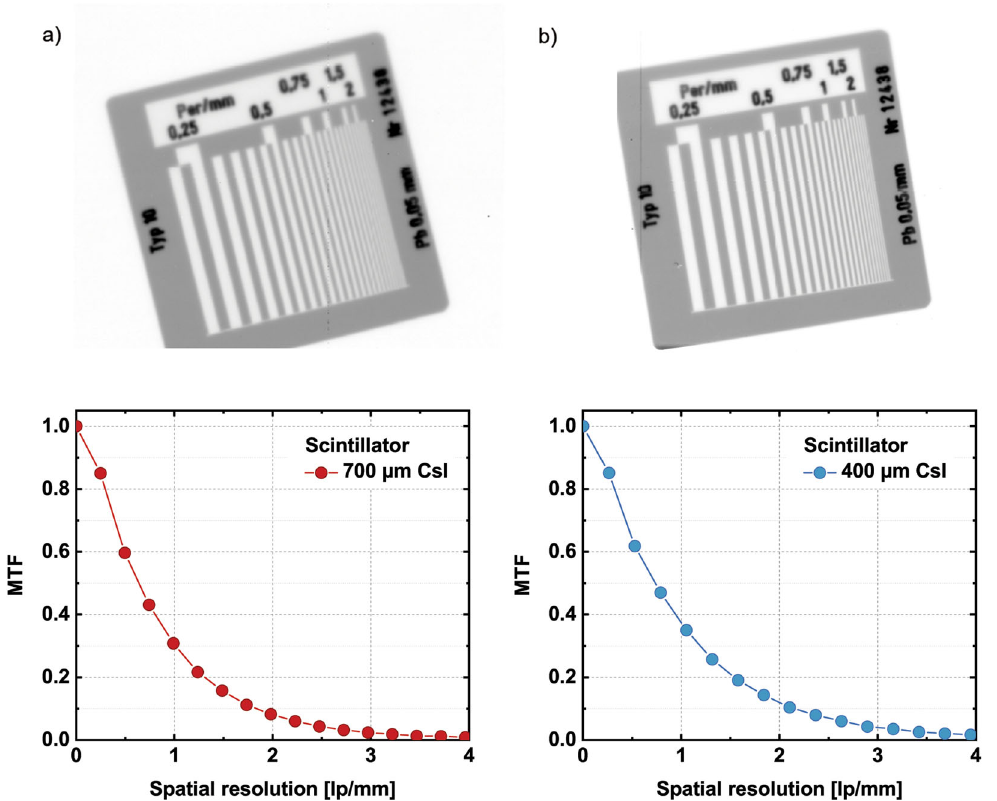
Fig. 6 2D X-ray characterization. a X-ray images of resolution phantom (Huettner, type 10, top) and MTF plot (bottom) with CsI scintillator of 400 µm thickness. b Same but with CsI scintillator of 700 µm thickness. X-ray settings: 70 kVp, 350 mA tube current, 50 ms exposure time, source-image distance 1